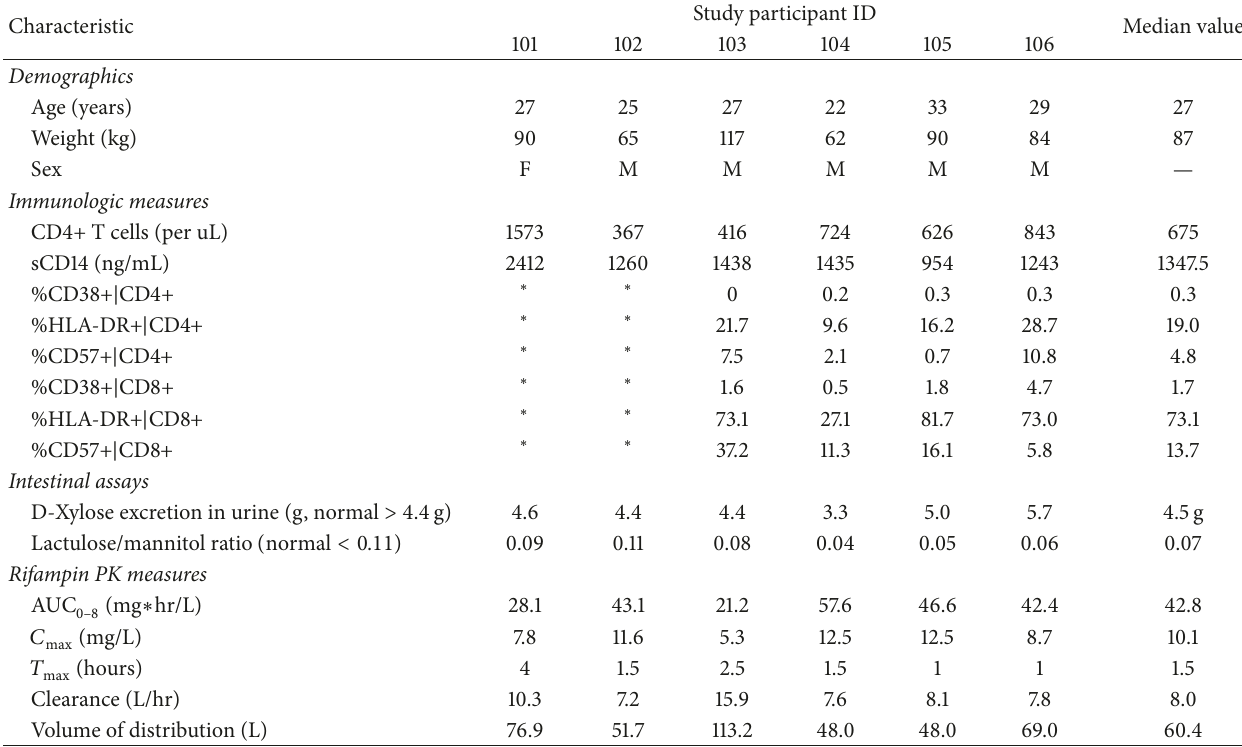
Table 1: Immune activation, intestinal assays, and rifampin PK